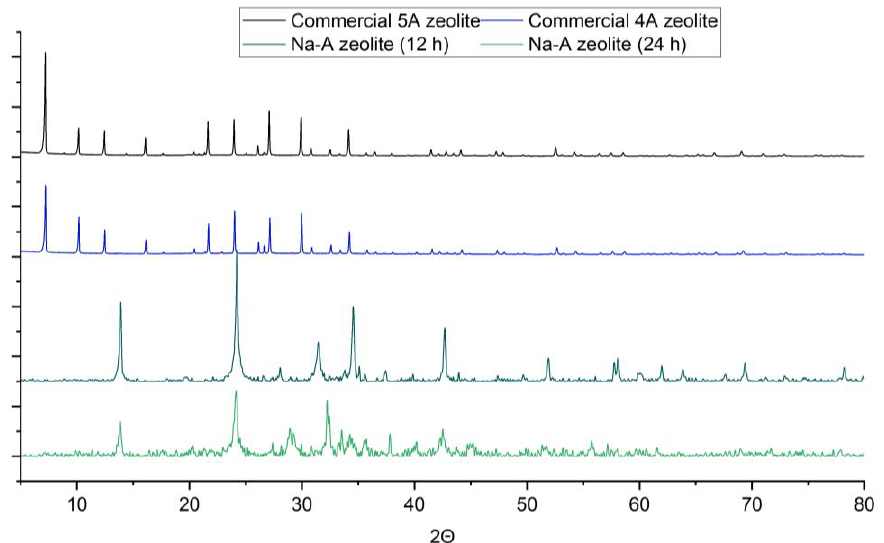
Figure 4. Phase Analisis Result Comparison, Commercial 4A Zeolite, Commercial 5A Zeolite, Syn- thesized Na-A Zeolite and Synthesized Na-A Zeolite (24